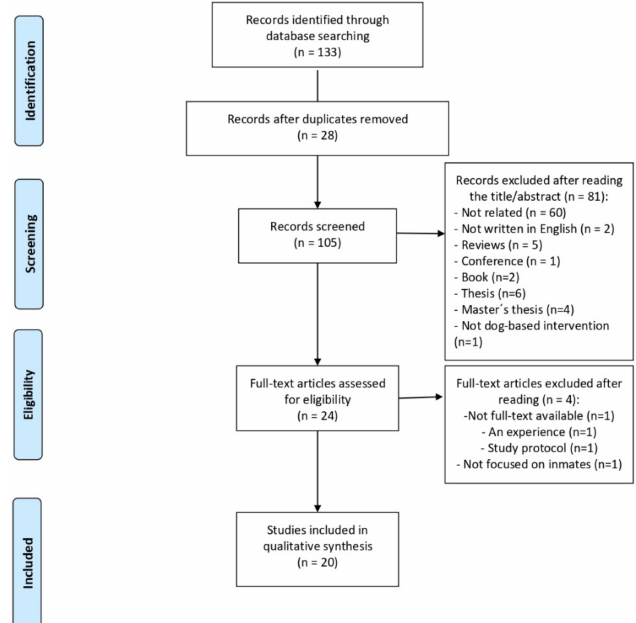
Figure 1. Flow chart for selection of